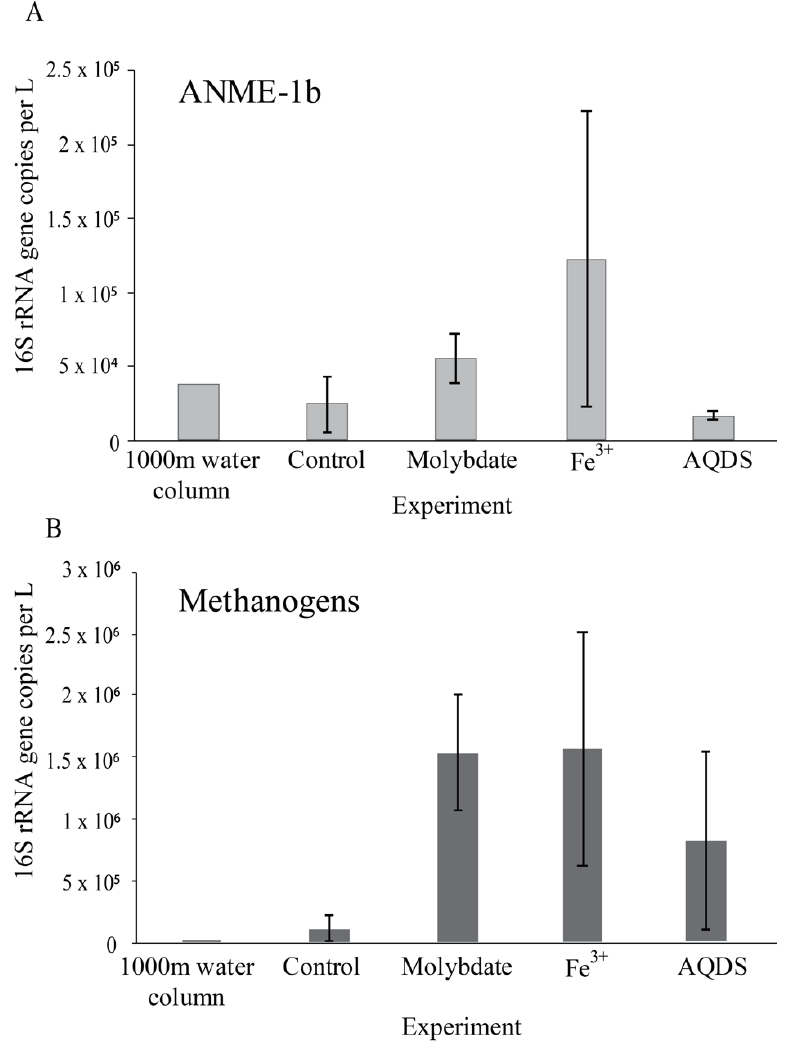
Figure 2. Abundance of ANME-1b ( A ) and methanogens ( B ); defined here as all species belonging to the Methanomicrobia, Methanococci, Methanobacteria, Methanomassiliicoccales, and Methanofastidiosales, (excluding any ANME) in natural Black Sea water from 1000 m depth and at the end of the various incubation experiments, in 16S rRNA gene copies per L. Values for duplicate bottles are averaged, except for the 1000 m sample, for which only one sample was used. Notice the different scale on the y-axis.